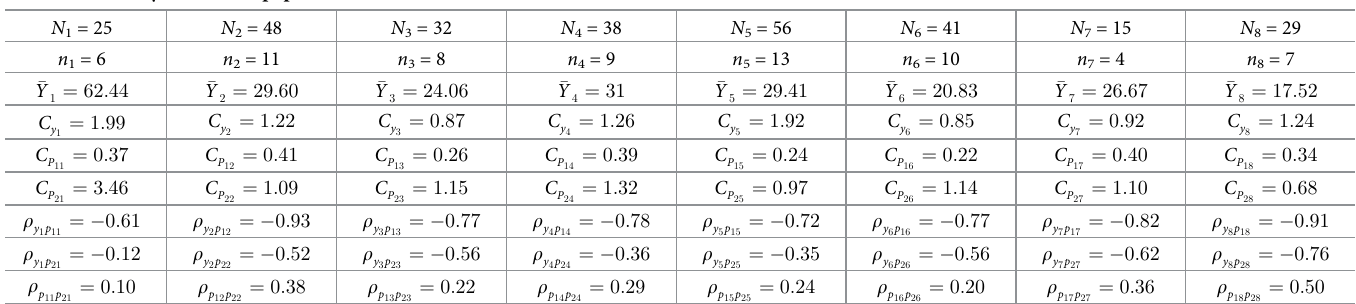
Table 6. Summary statistics of population